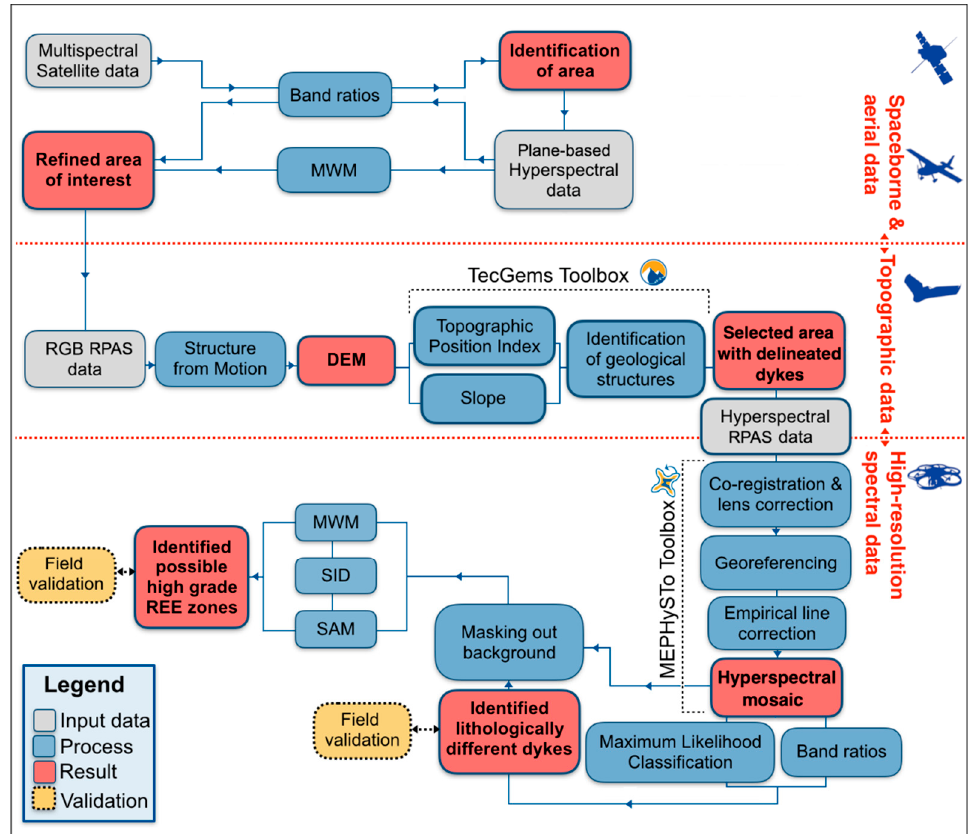
Figure 4. The processing workflow of the data captured at Lofdal. The data captured consisted of satellite, airplane-, and RPAS-based. It indicates the integration of topographic with spectral information. The top section of the workflow depicts the processing methods performed on the ASTER and HyMap data while the middle and lower sections show the processing methods performed on the RPAS-based